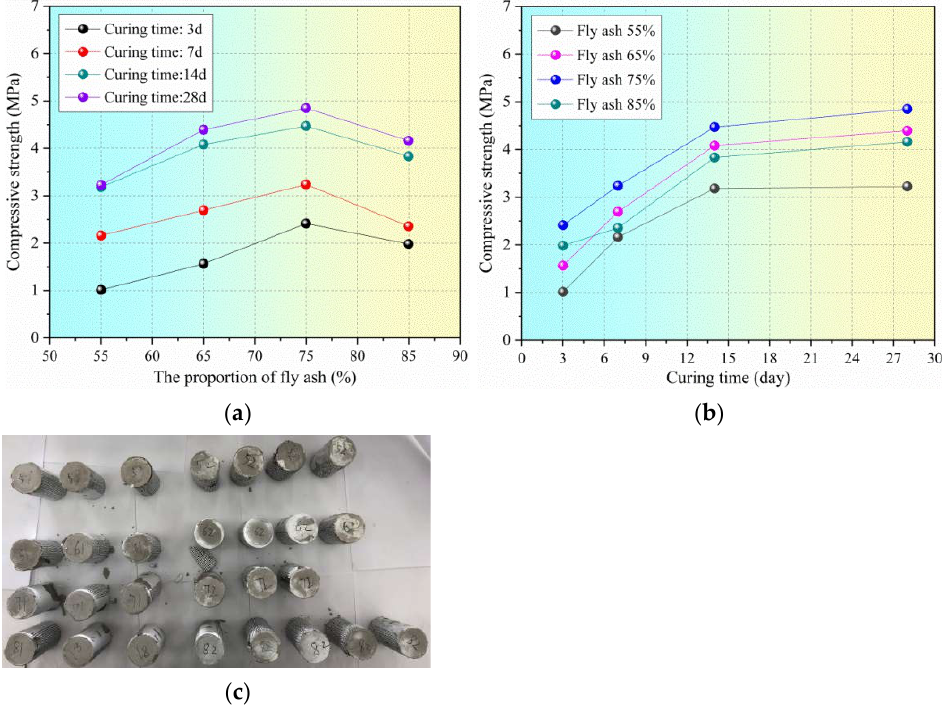
Figure 5. The UCS of CMFB with various fly ash contents and curing times. ( a ) Various fly ash contents; ( b ) various curing times; ( c ) some damaged specimens after the UCS test.